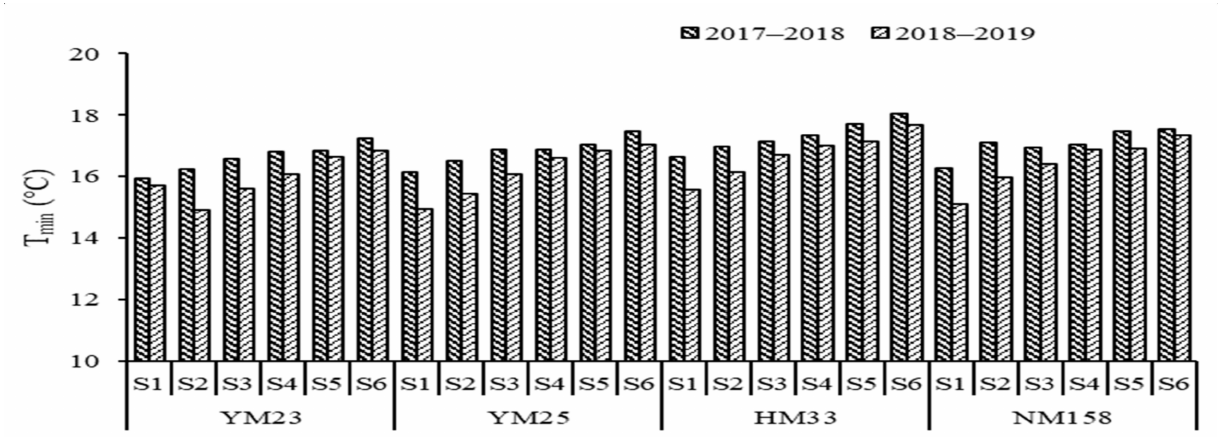
Figure 7. Change in daily minimum temperature (T min ) after anthesis on different sowing dates.